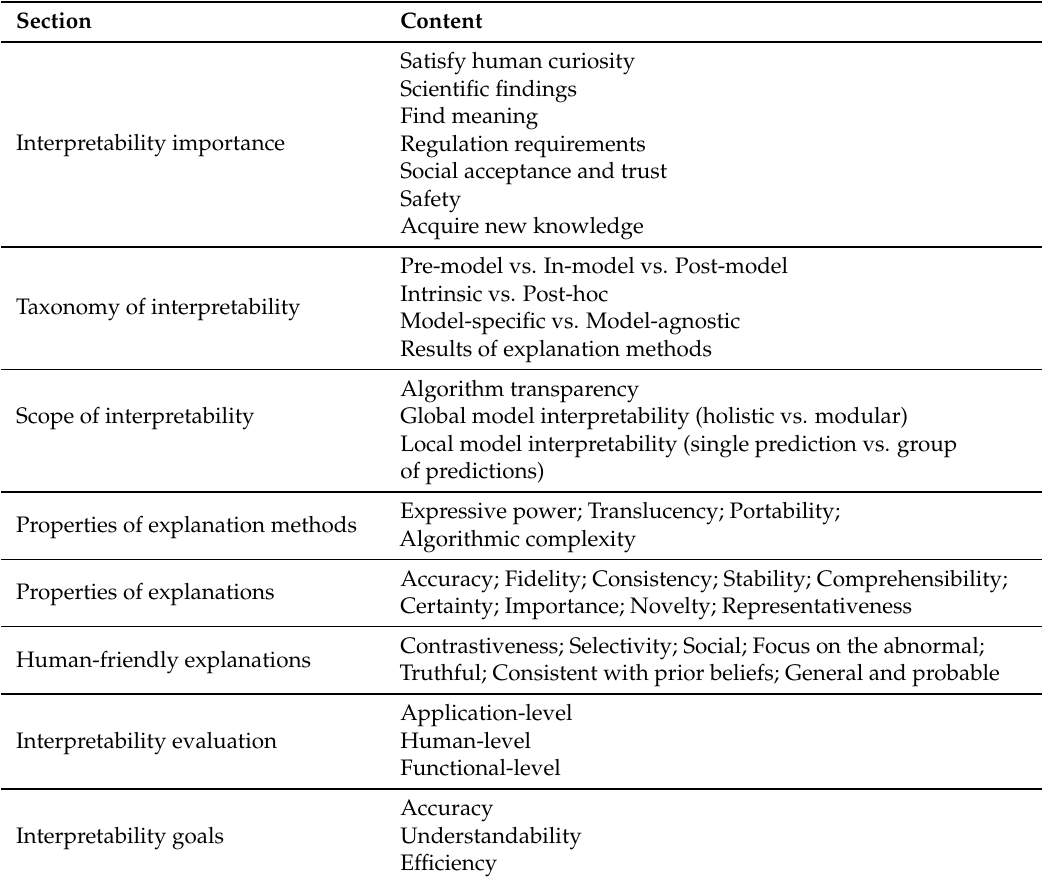
Table 5. Literature review